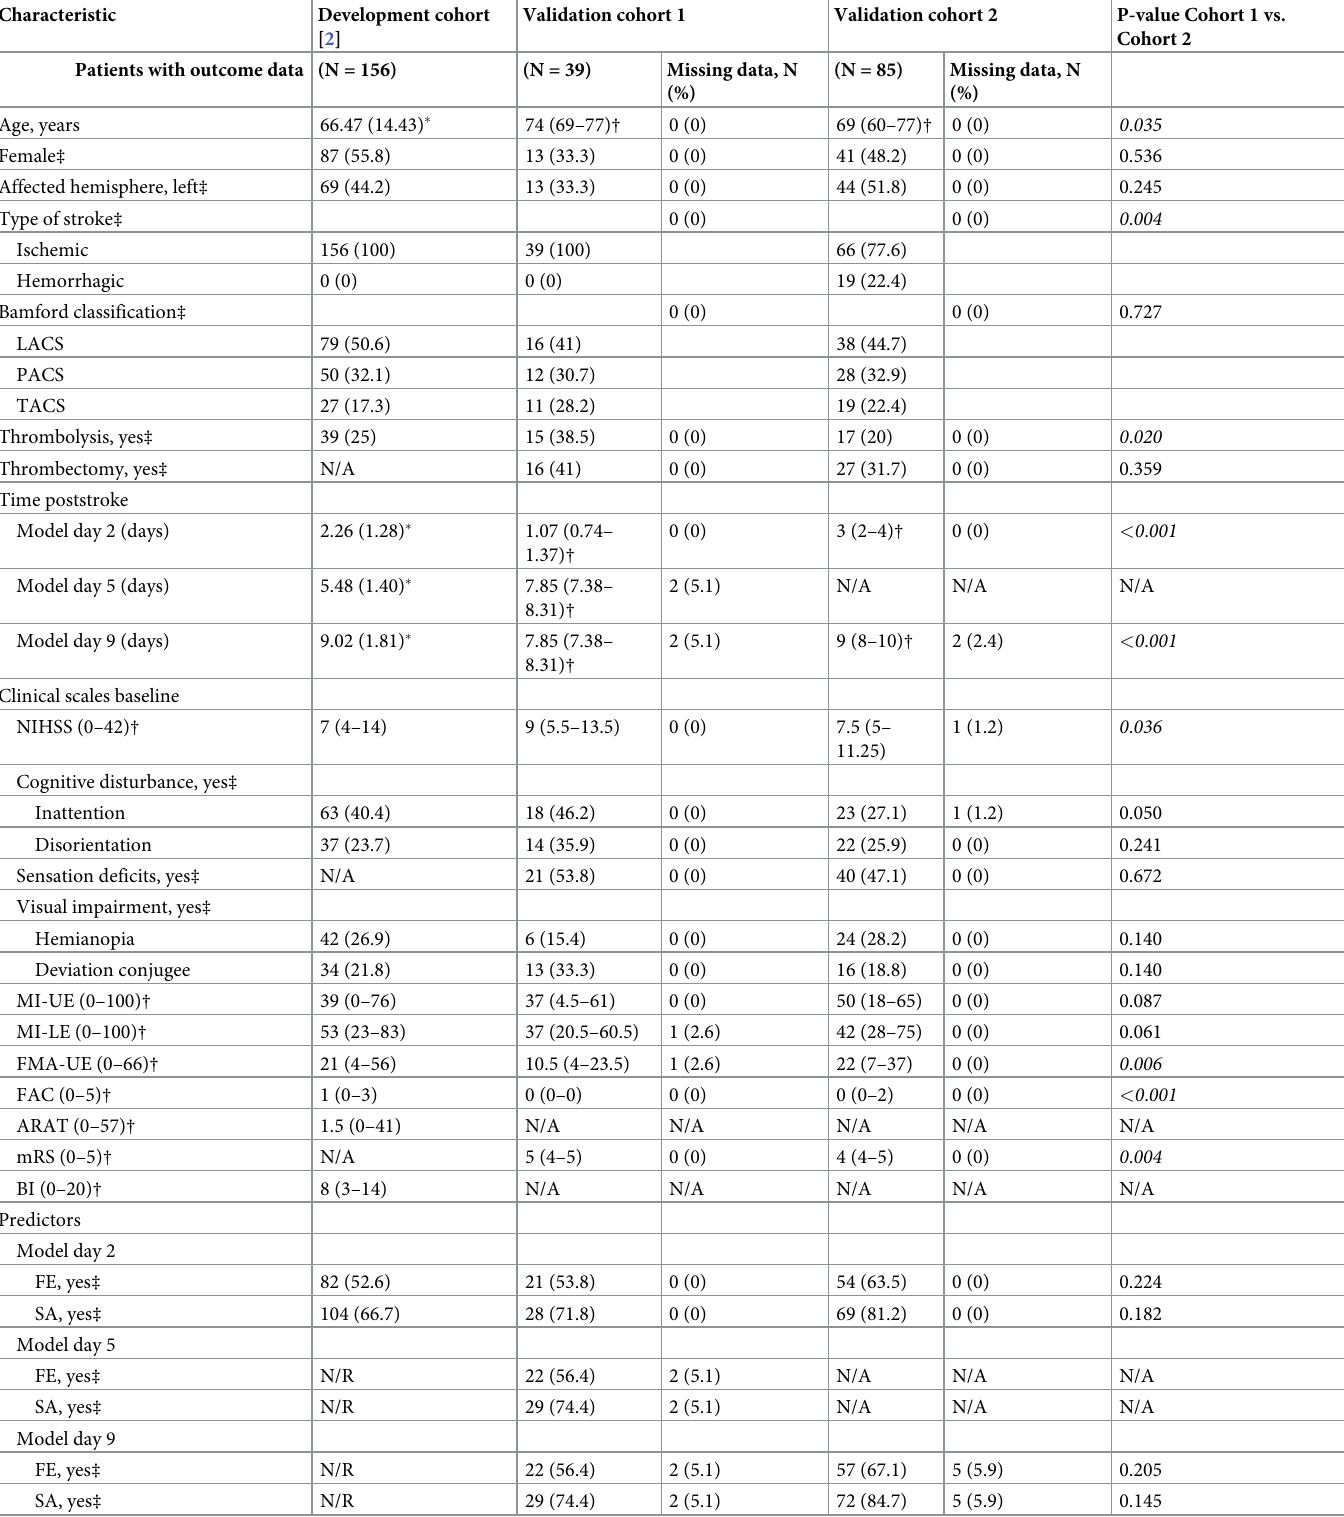
Table 2. Characteristics of included patients who were analyzed for model development and external